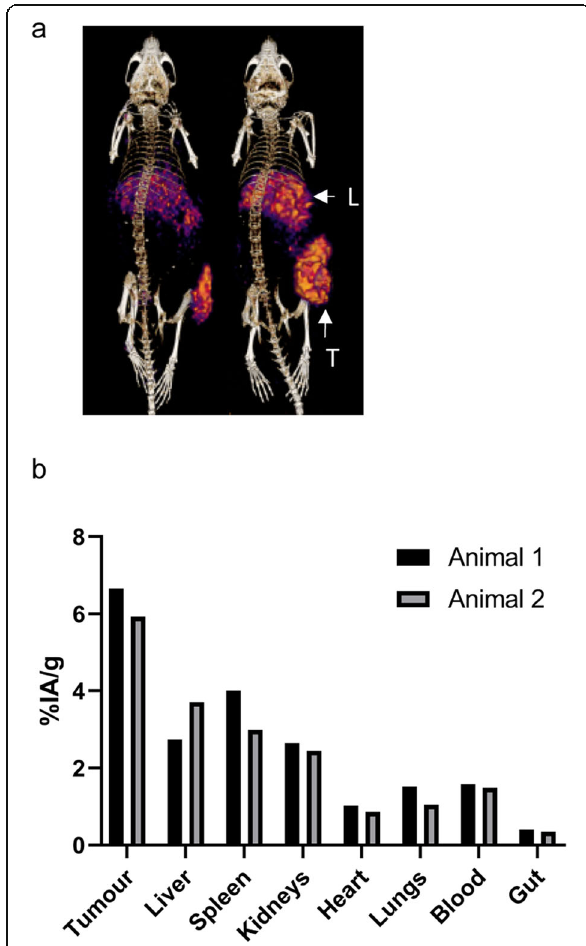
Fig. 1 Imaging of [ 89 Zr]Zr-DFO-Miltuximab® in BALB/c/nude mice. a PET-CT imaging of mice ( n = 2) bearing a DU-145 xenograft on day 7 post intravenous injection of [ 89 Zr]Zr-DFO-Miltuximab®. T, tumour; L, liver. b Biodistribution of [ 89 Zr]Zr-DFO-Miltuximab® in BALB/c/nude mouse organs 7 days after injection of [ 89 Zr]Zr-DFO-Miltuximab® ( n = 2) by ex vivo analysis of organs by gamma counter. Data are expressed as %injected activity (IA)/gram